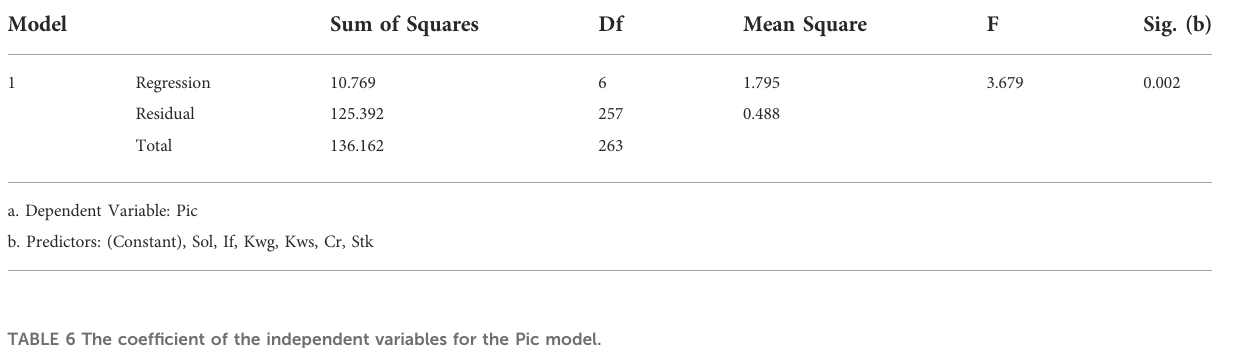
TABLE 5 ANOVA corresponding to the dependent variable for Pic.